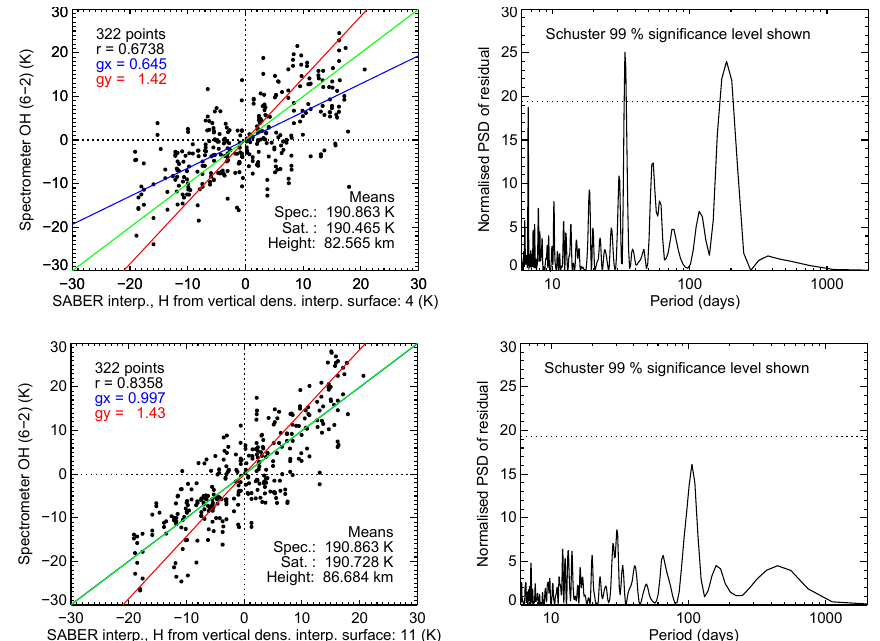
Figure 7. Two examples of the comparison between the spectrometer OH temperatures and the SABER temperatures interpolated to constant density surfaces. The panels on the left show the correlation values between the spectrometer and SABER temperatures for two density surfaces. The blue and red lines indicate lines of best fit made assuming that all experimental errors are in the SABER and spectrometer, respectively. The green line indicates the y = x line. The right-hand panels indicate Lomb–Scargle periodograms for the residuals between the spectrometer and SABER temperatures corresponding to the left-hand panels. Table 4. Comparison between coincident TIMED SABER and spectrometer temperatures for the period 16 July 2002 to 25 January 2004 when the meteor radar data were available to calculate the neutral density. N is the number of points in each sample. See text for further